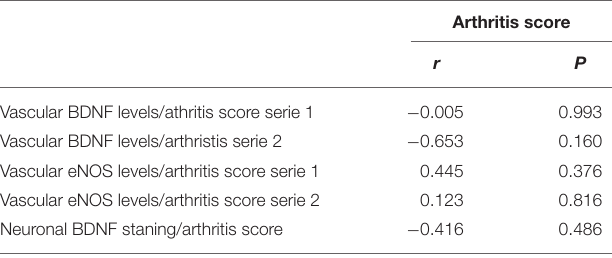
Arthritis score r P